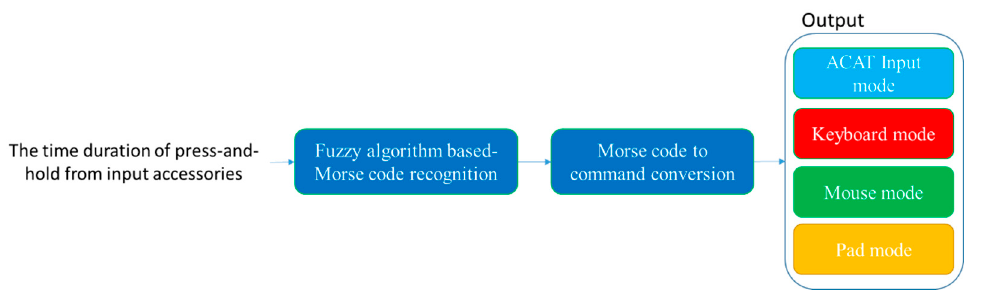
Figure 3. Functional block diagram of MCT.